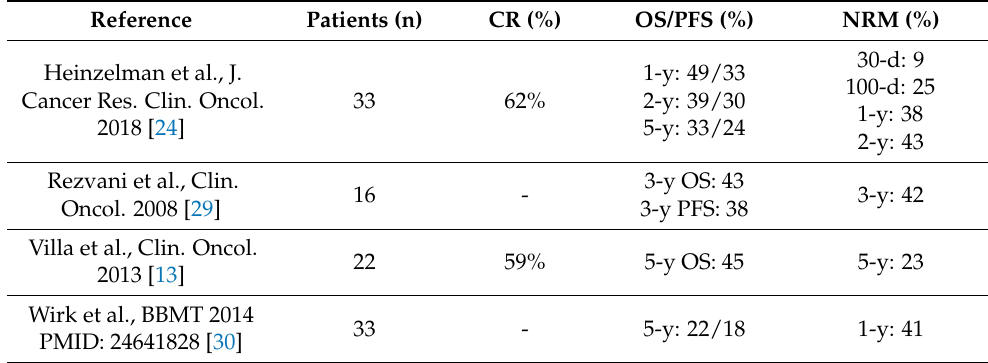
Table 4. Previously published